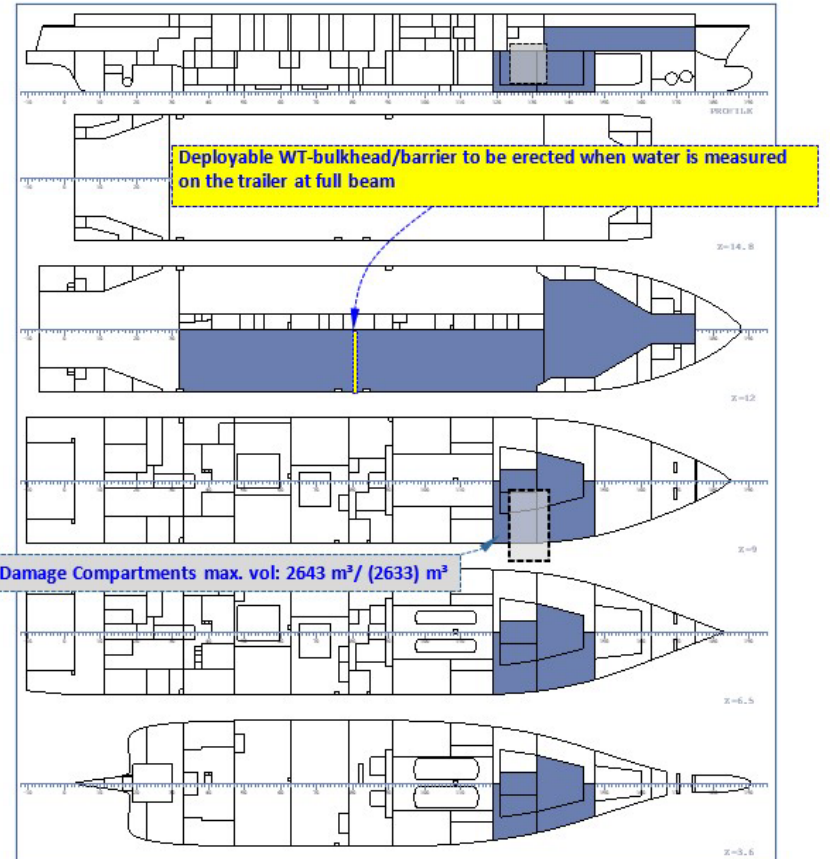
Figure 16. Damage Case 4 with watertight barrier on the trailer deck: The grey rectangle shows the damage penetration. The damaged compartments T001, T043, T045, T046, T083, and T098 are shown with dark blue-grey, the barrier to block the floodwater spreading on the trailer deck with yellow. The first water volume is the one in the numerical model, the value in brackets is the value realized in the scale model used in the model tests.